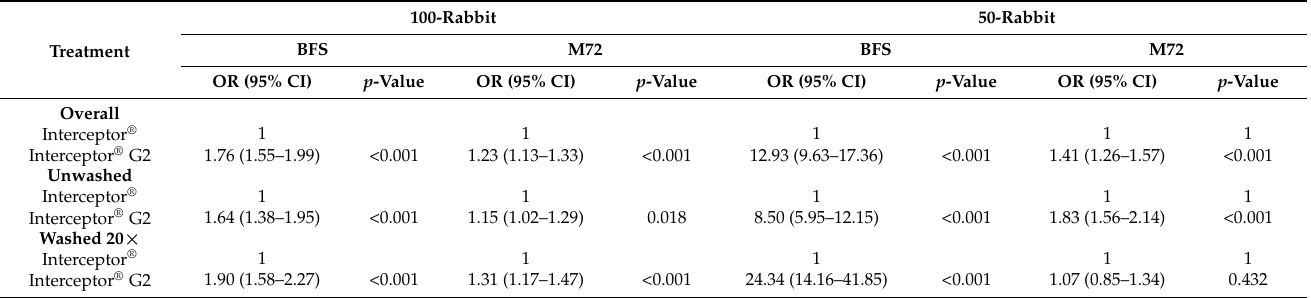
Figure 6. Mean and 95% confidence Interval (CI) for ( A ) 24 h mortality (M24), ( B ) blood feeding inhibition (BFI) of Interceptor ® ITN with 100 vs. 50 pyrethroid susceptible Anopheles gambiae ; ( C ) 72-h mortality (M72); and ( D ) BFI of Interceptor ® G2 ITN with 100 vs. 50 pyrethroid-resistant Anopheles arabiensis in the WHO tunnel test. Red dashed line depicts WHO minimum bioefficacy thresholds of ≥ 80% M24 and ≥ 95% BFI. Table 5. Superiority of Interceptor ® G2 over Interceptor ® using 100 versus 50 resistant mosquitoes: The difference in the odds of mosquito at 24 h (M24) and 72 h (M72) and blood feeding success (BFS) for pyrethroid-resistant Anopheles arabiensis exposed to Interceptor ® G2 and Interceptor ® in the gold standard rabbit-100 and 50-rabbit mosquitoes